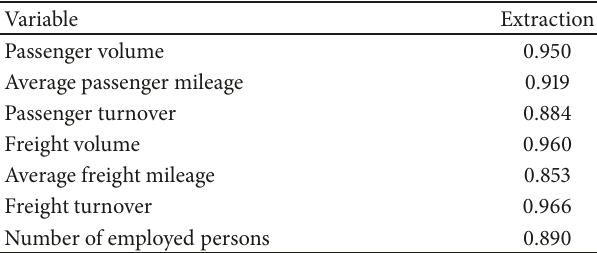
Table 4: Communality of indicators.